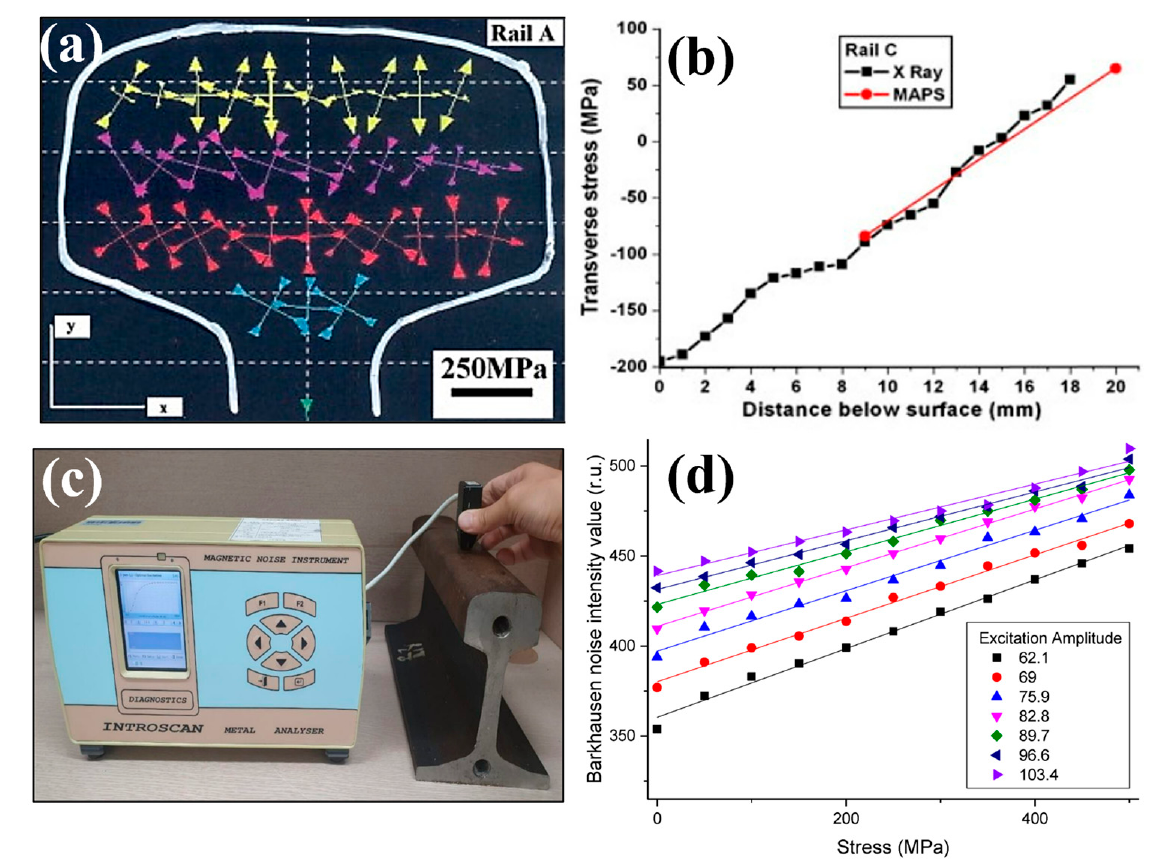
Figure 10. Study by Lo et al. [92] showing ( a ) grid lines of measurements locations and MAPS readings on a railhead, ( b ) comparison of X-ray and MAPS stress measurements. Study by Hwang et al. [93] ( c ) MBN measurements on a rail and ( d ) profile of noise intensity and stress for MBN measurements.